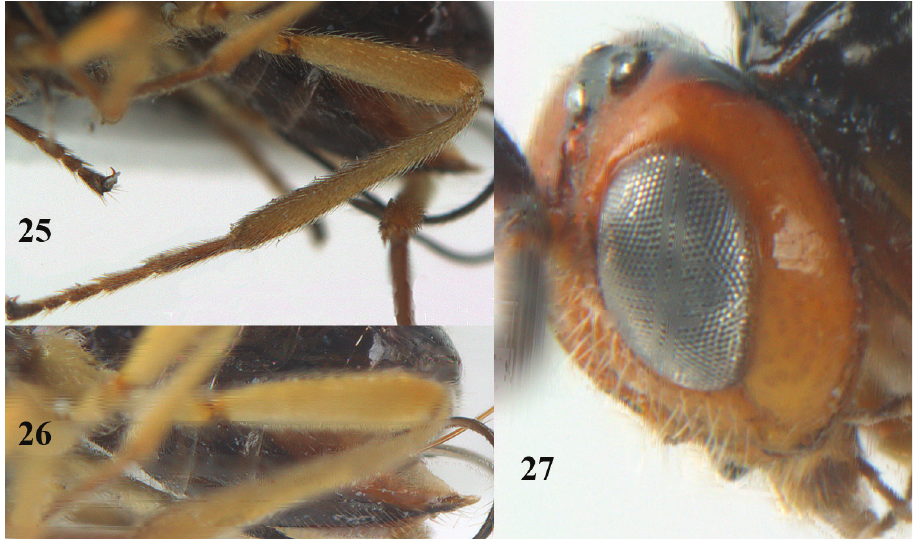
Figures 25–27. Psyttalia cyclogaster (Thomson), ♀ , China, Ningshan. 25 hind leg lateral 26 hypopygium lateral 27 head